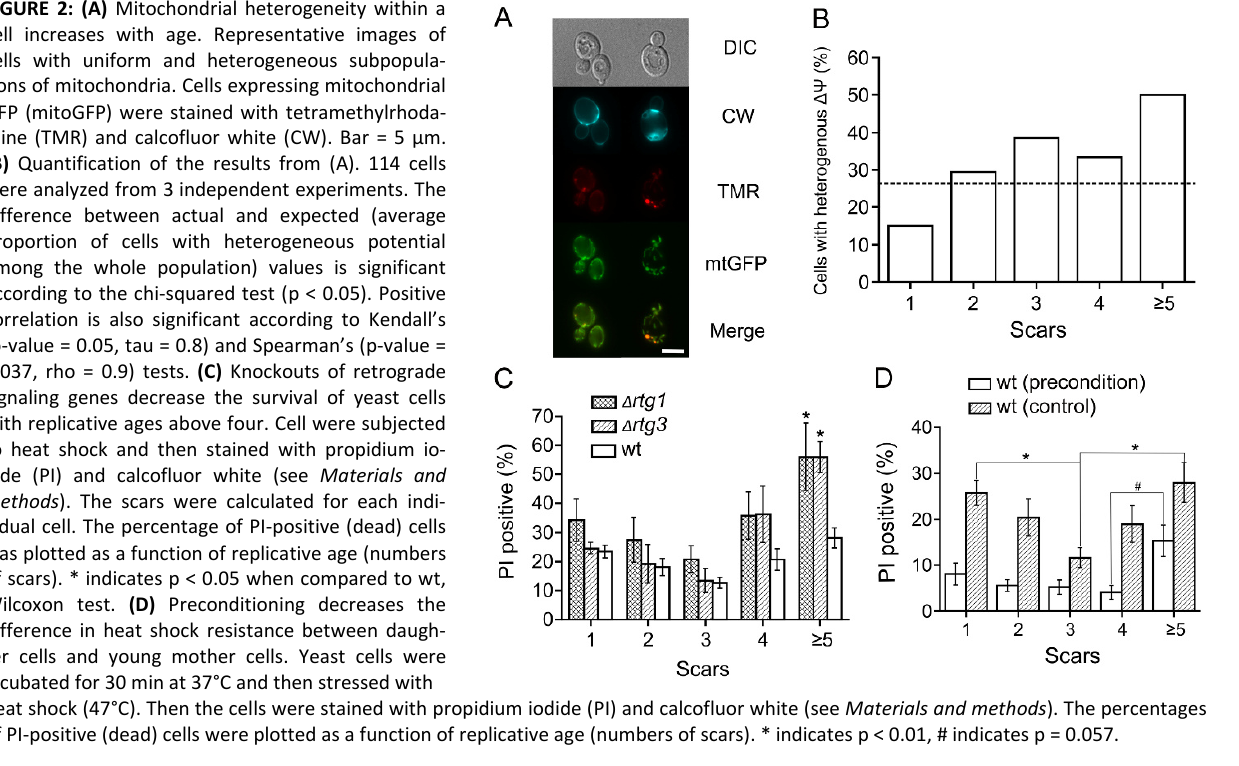
OPEN ACCESS | www.microbialcell.com 39 Microbial Cell | January 2014 | Vol. 1 No. 1